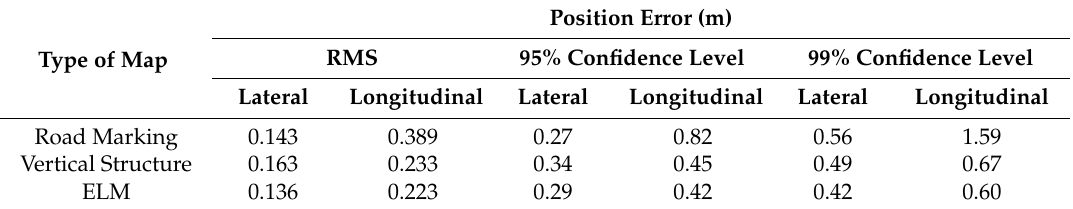
Table 2. Localization performances of three